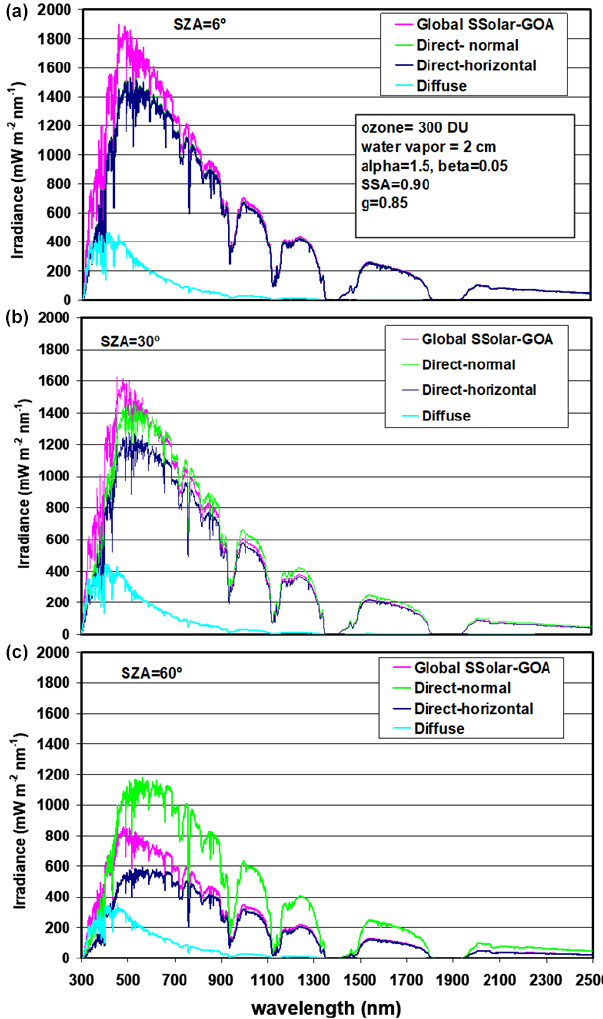
Figure 2. Global, direct normal, direct-horizontal, and diffuse spec- tral solar irradiances simulated at sea surface level according to the input parameters shown in the figure for SZAs of 6, 30, and 60 ◦ , respectively (from top to